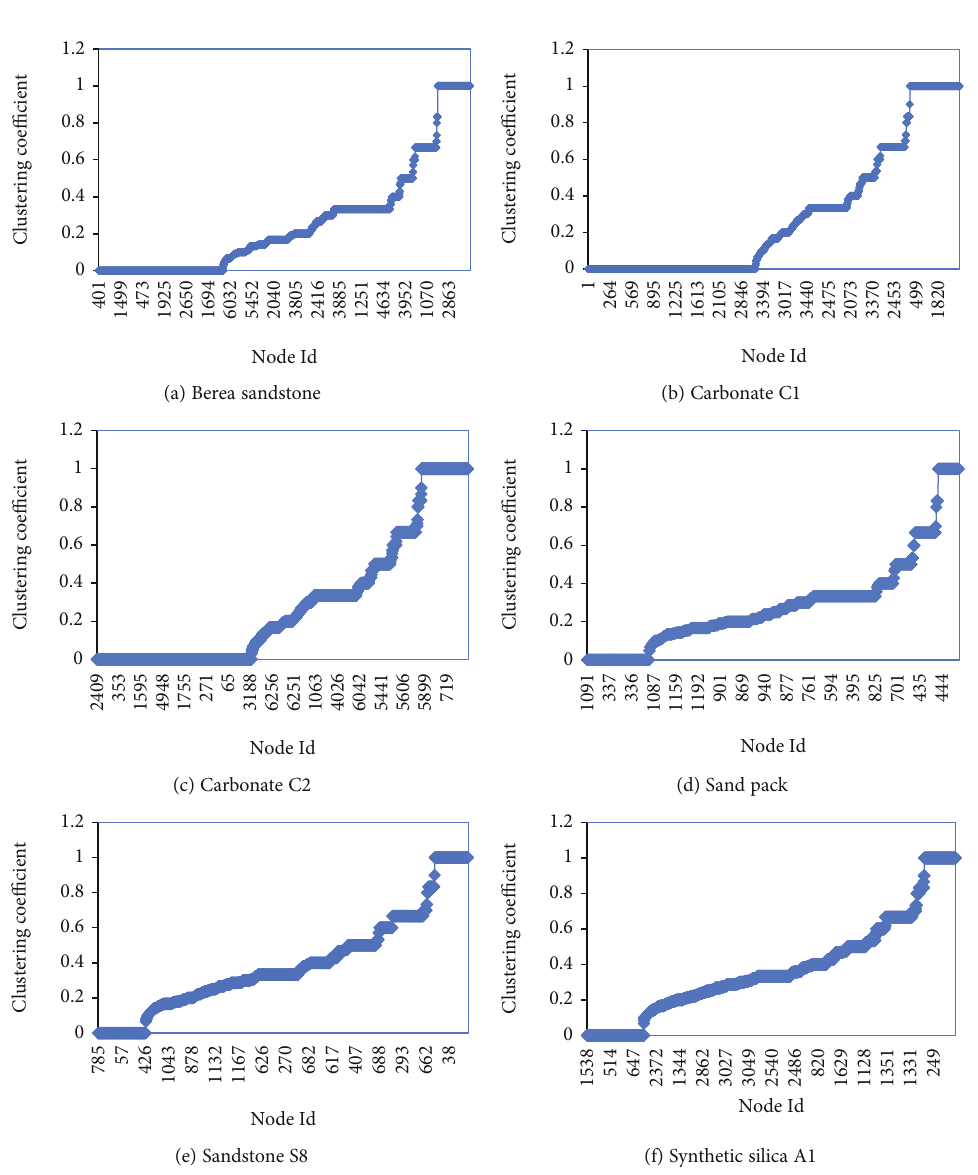
Figure 6: Clustering coe ffi cient of